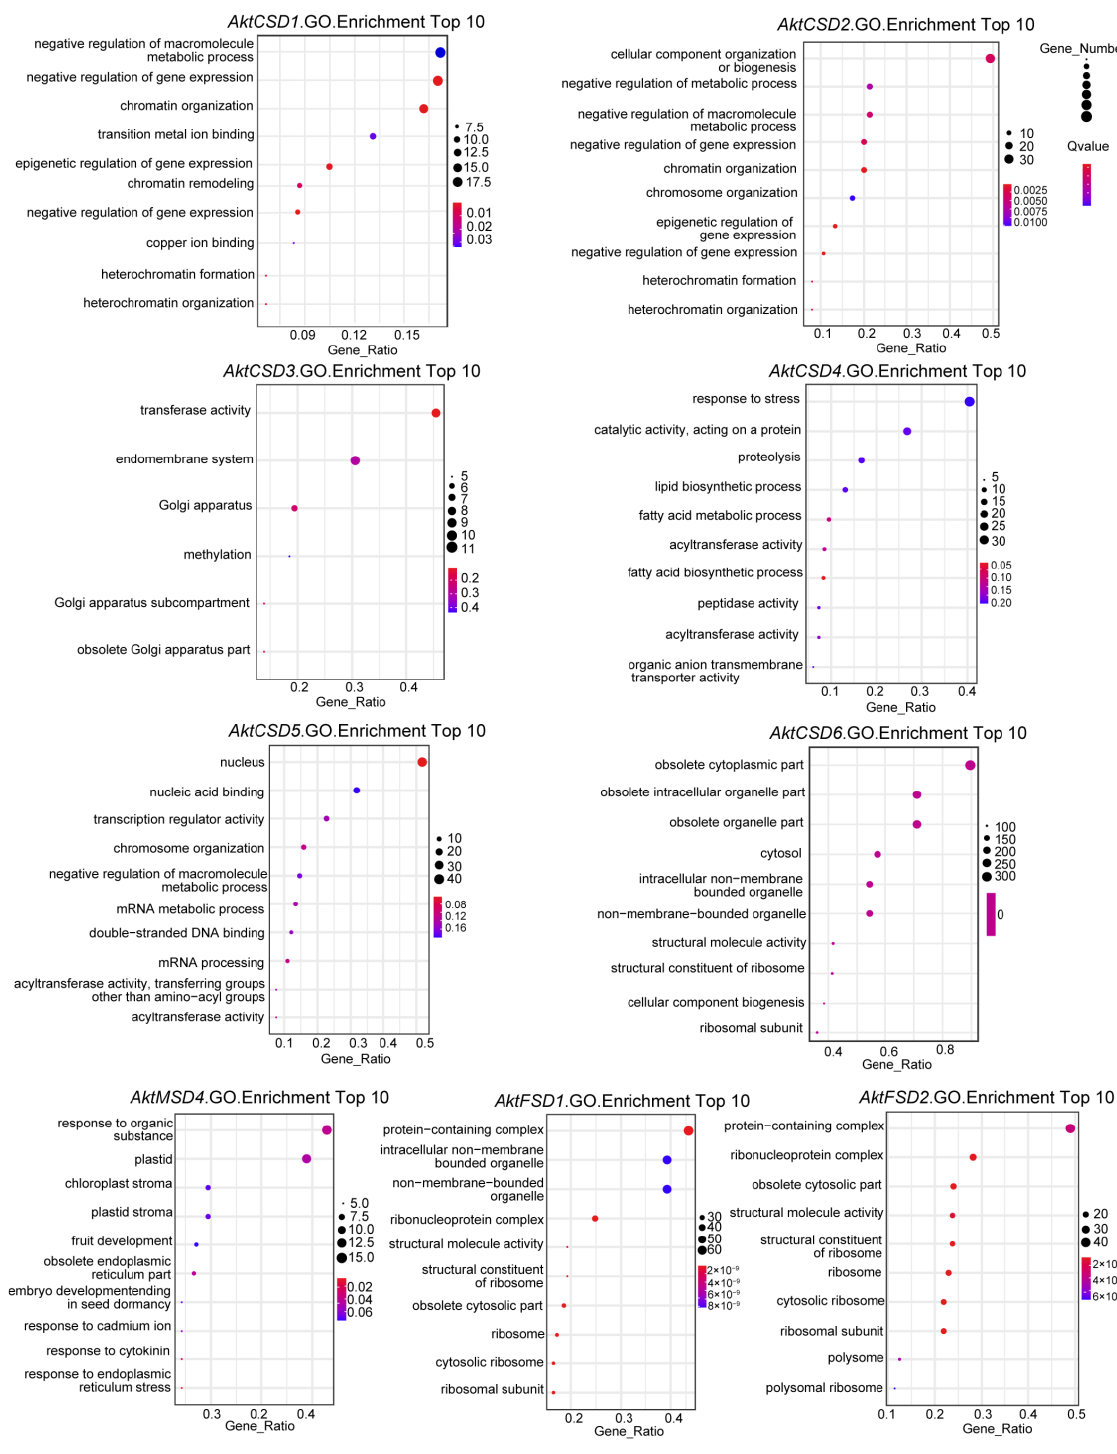
Figure 6. GO enrichment analysis of gene sets associated with AktSOD expression.